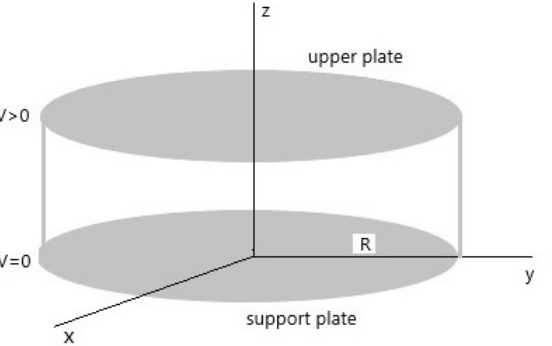
Figure 1. A 2 D electrostatic circular membrane MEMS device whose metal plates (upper and support ones) are displayed in gray. Between them, a circular membrane, clumped to the edges of the support plate, deforms towards the upper plate without touching it to avoid unwanted electric